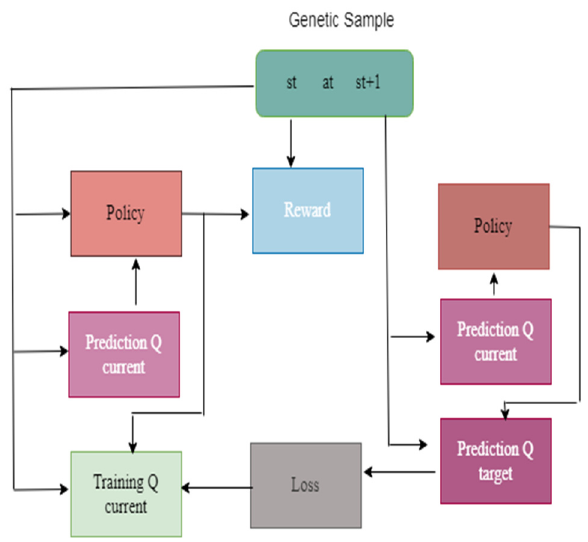
Figure 5. Framework of the DDQN Model.